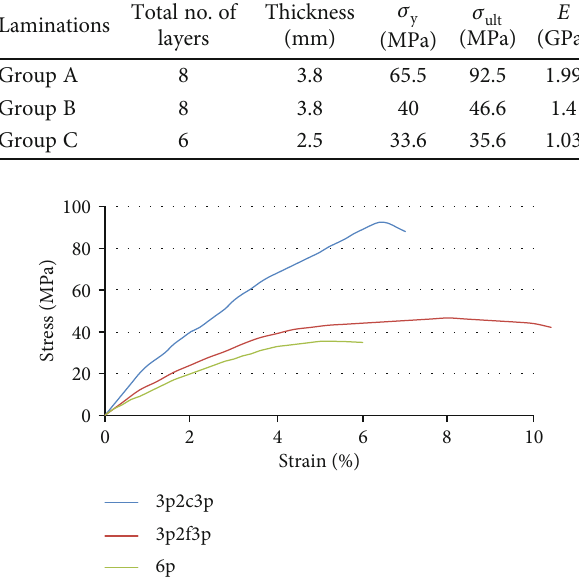
Table 2: Mechanical properties for each group. Total no. of Laminations layers